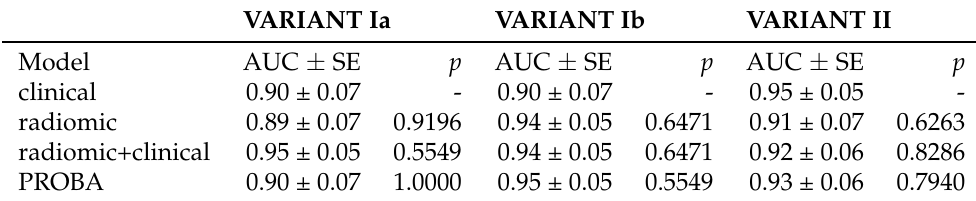
Table 3. Comparison between best models with and without radiomic features.